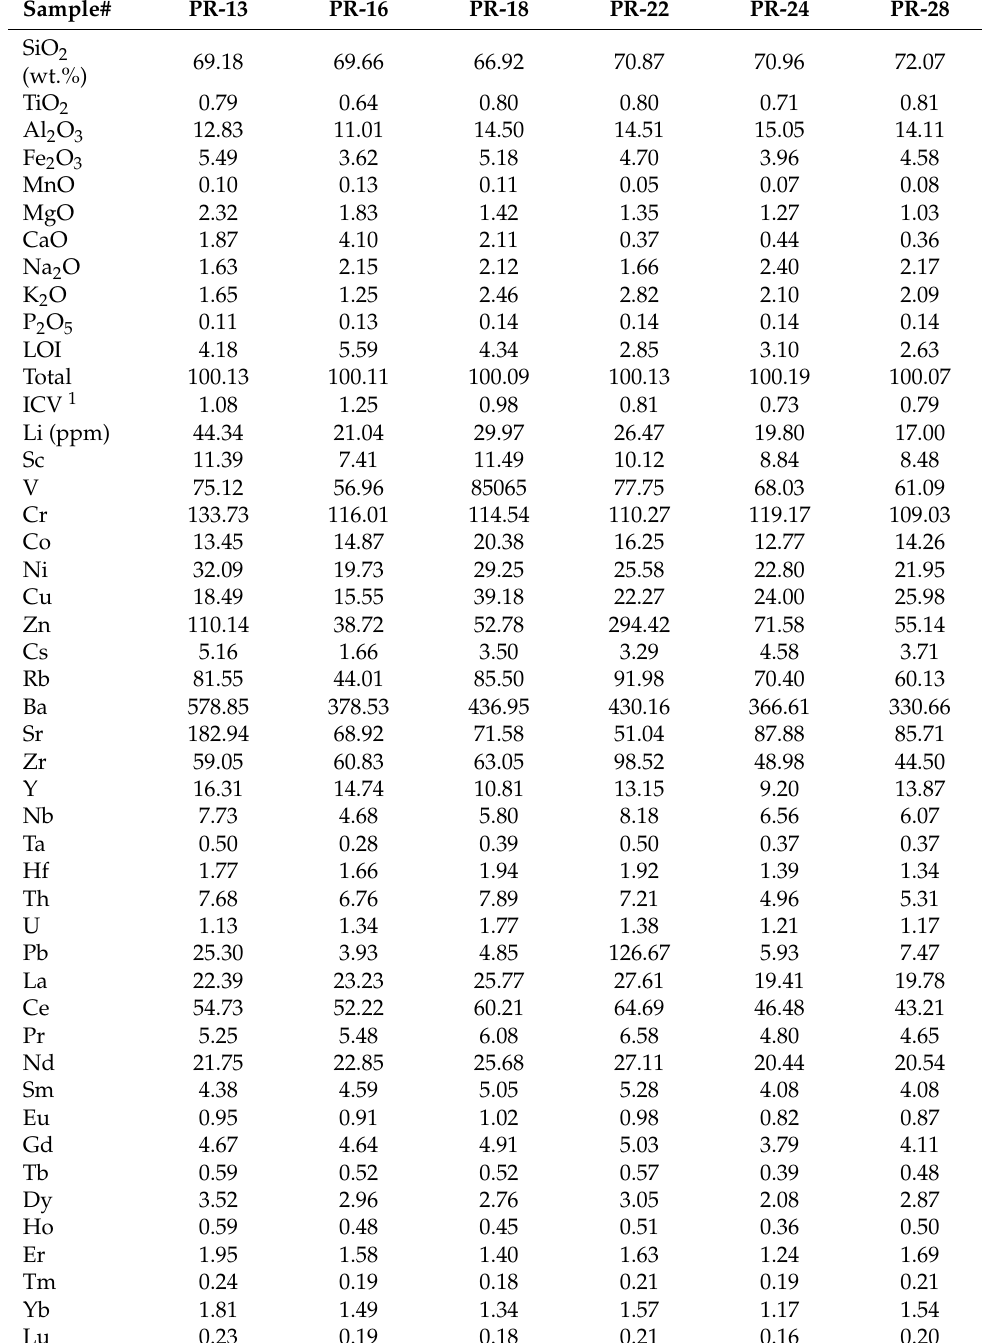
Table 2. Chemical composition of Paleozoic volcaniclastic sediments from the Priorat DOQ region